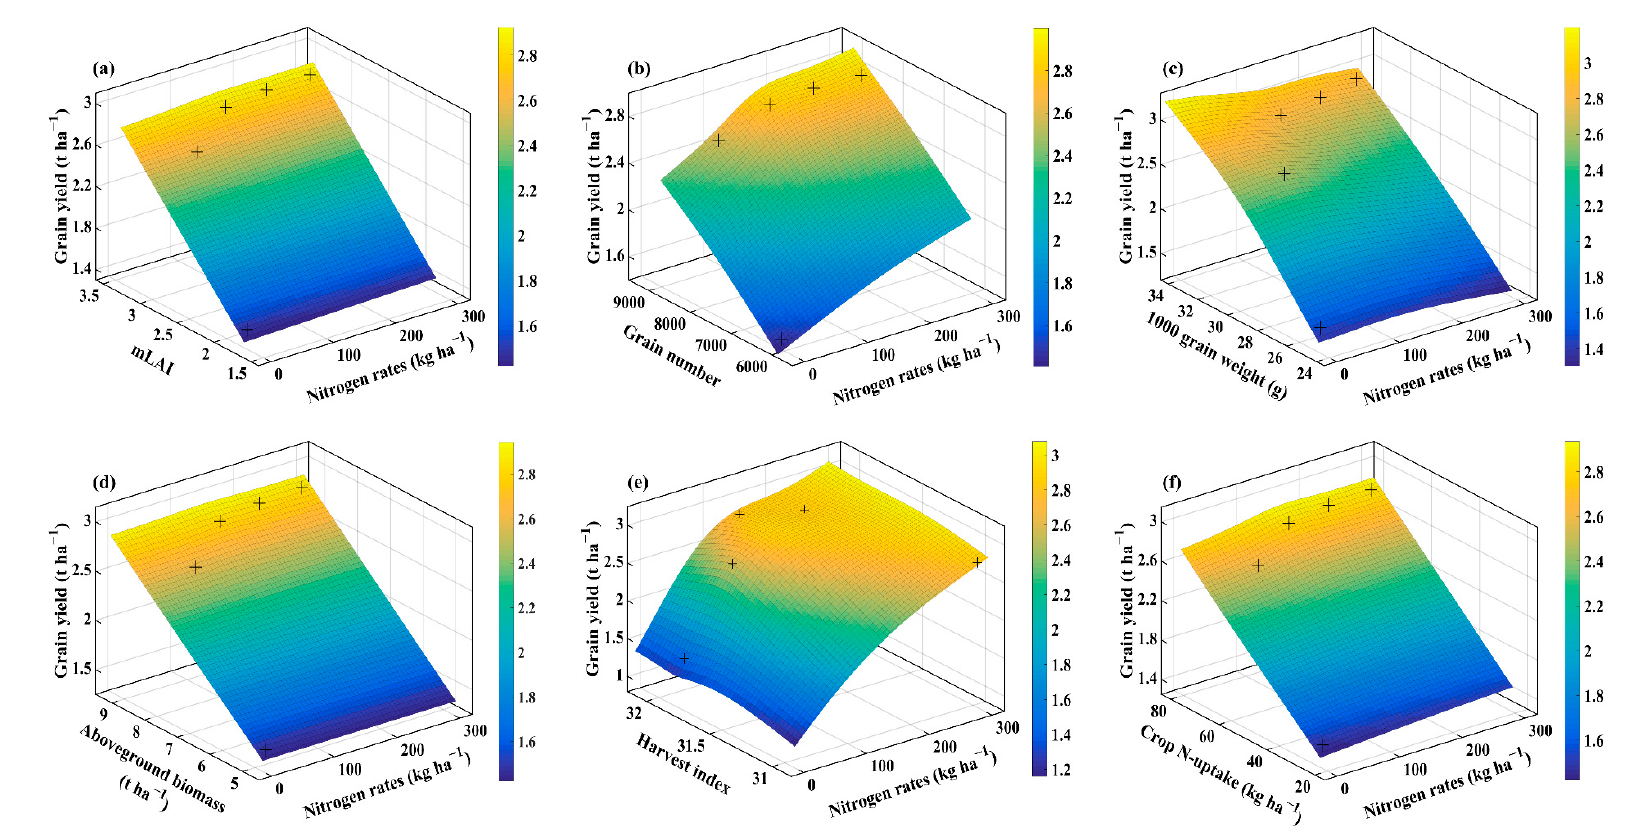
Figure 6. Thin plate smoothing spline plots showing the interaction of N rates ( x -axis) with mLAI, grain number, 1000 grain weight, aboveground biomass, harvest index, and crop N-uptake ( y -axis) on average grain yield ( z -axis) in 2014–2015 growing season. The various panels show mLAI ( a ); grain number ( b ); 1000 grain weight ( c ); aboveground biomass ( d ); harvest index ( e ); and crop N-uptake ( f ) for the 2014–2015 growing season, respectively. + indicates the observed data.